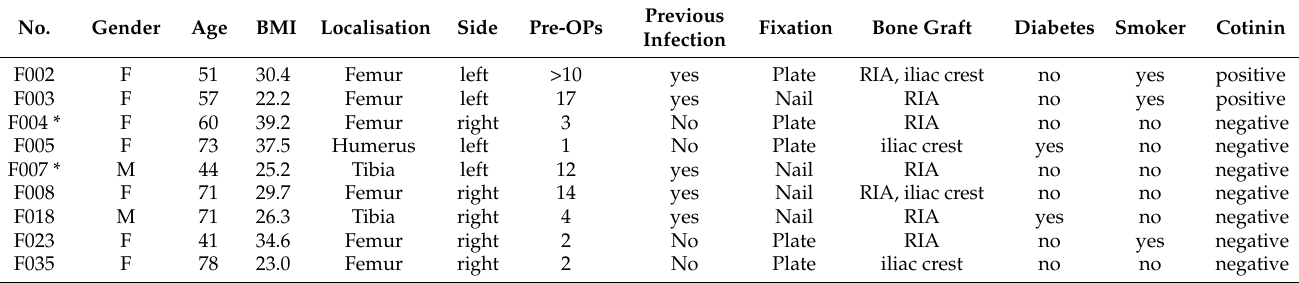
Table 2. Study group Non-Responder.